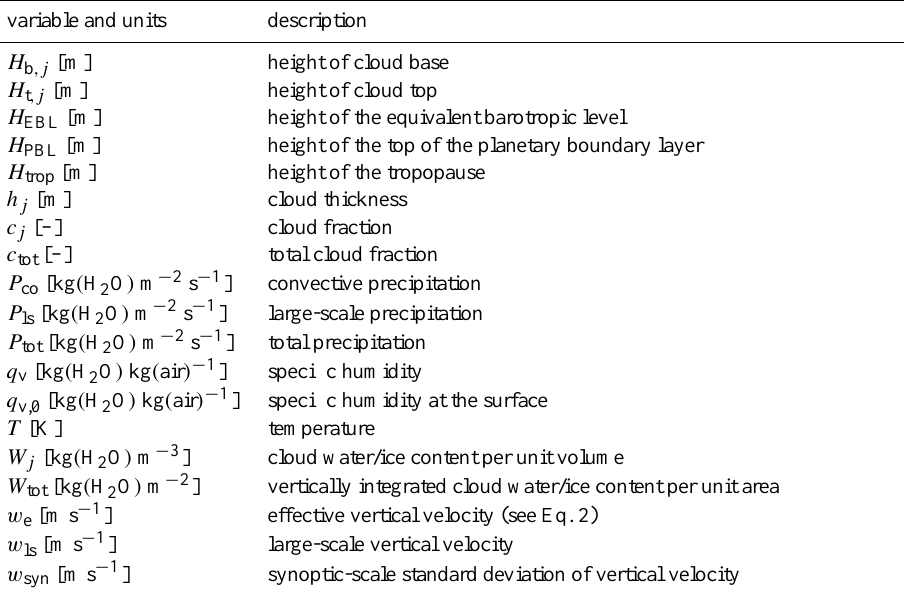
Table 1. List of symbols used throughout the paper. Long dash in the first column indicates that the corresponding variable is non- dimensional. Variable modifiers: j indicates cloud type ( = sl , sm , sh , co), and k stands for cloud phase ( = drop ,